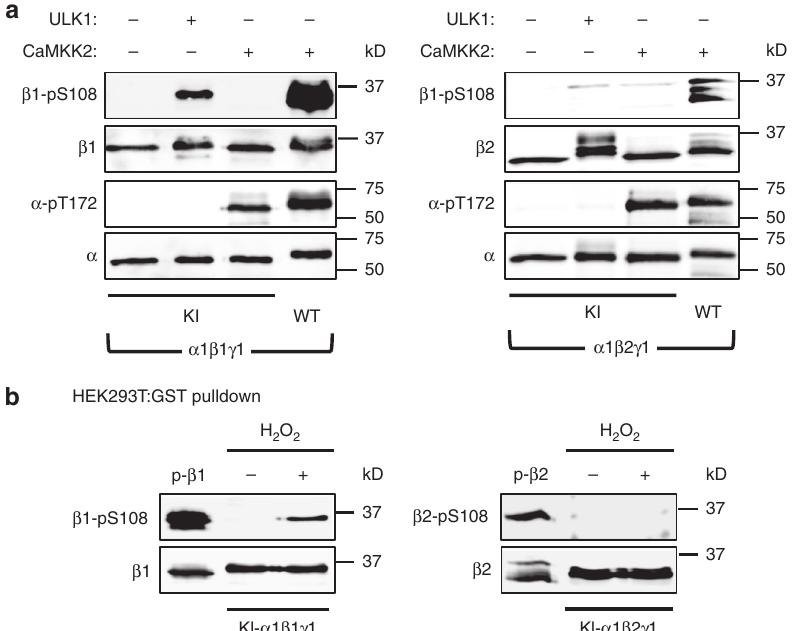
Fig. 5 ULK1 phosphorylation of Ser108 is speci fi c for the AMPK β 1 isoform. a Immunoblots for β 1-pSer108, β 2-pSer108, and α -pThr172 in bacterial- expressed KI- α 1 β 1 γ 1 ( left ) or KI- α 1 β 2 γ 1 ( right ) phosphorylated with ULK1 or CaMKK2 for 30 min. Controls: CaMKK2-treated WT α 1 β 1 γ 1 ( left ) or α 1 β 2 γ 1 ( right ). b Immunoblots for β -pSer108 in KI- α 1 β 1 γ 1 ( left ) or KI- α 1 β 2 γ 1 ( right ) puri fi ed from HEK293T cells stimulated with 1 mM H 2 O 2 for 45 min. Controls: p- β 1 and p- β 2, CaMKK2-treated WT α 1 β 1 γ 1 and α 1 β 2 γ 1, respectively. In both panels n = 3, representative immunoblots ULK1 phosphorylation of β -Ser108 is speci fi c to AMPK β 1 . Ser108 is conserved between mammalian AMPK β -isoforms 1 and 2, however identity of the β 2 sequence to the ULK consensus/